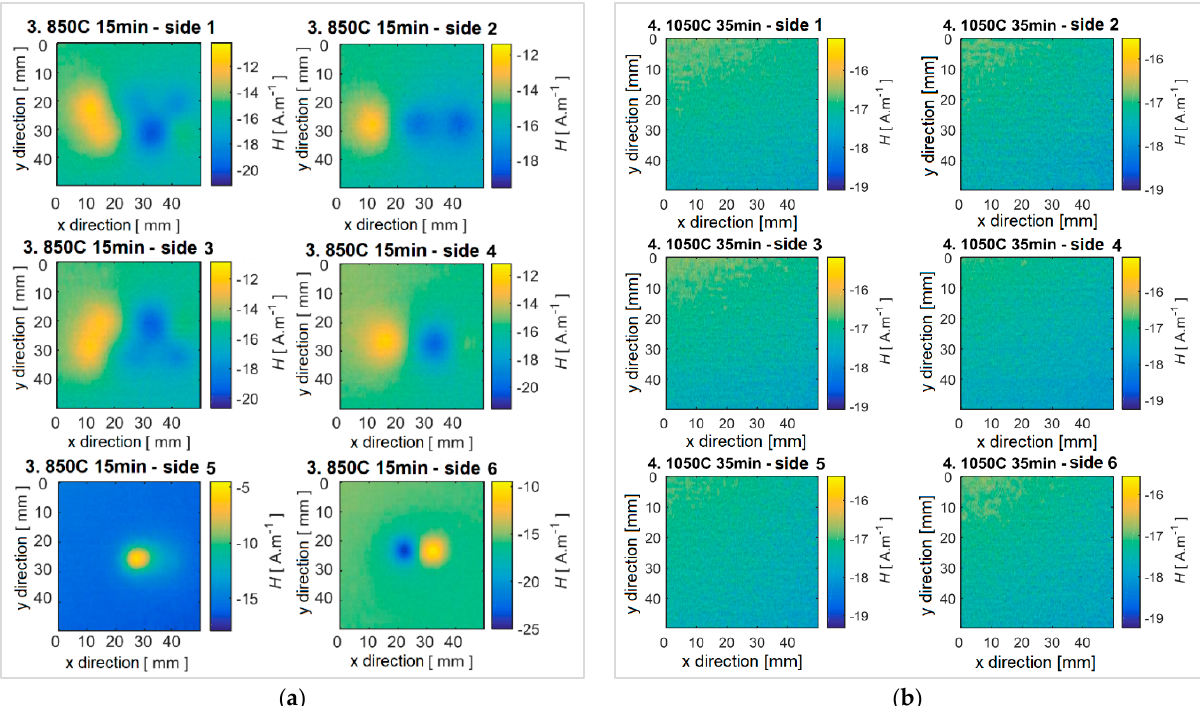
Figure 9. Distribution of the magnetic field of the specimen ( a ) No. 3 and ( b ) No. 4. An interesting fact is the comparison of the position of the maxima and minima of the magnetic field of the specimens. Figure 10a,b show the values of the maximum or